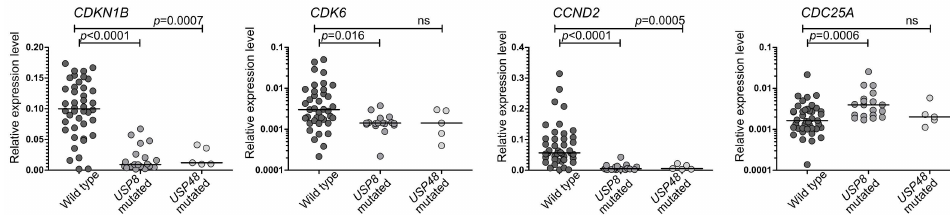
Figure 1. The expression of selected genes encoding cell cycle-related proteins in corticotroph PitNETs stratified according to deubiquitinase gene mutation